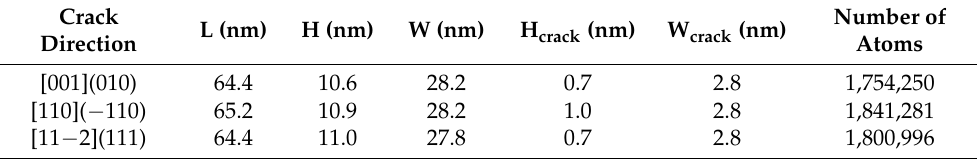
Table 1. Model parameters and numbers of atoms in the three center crack specimens. Crack